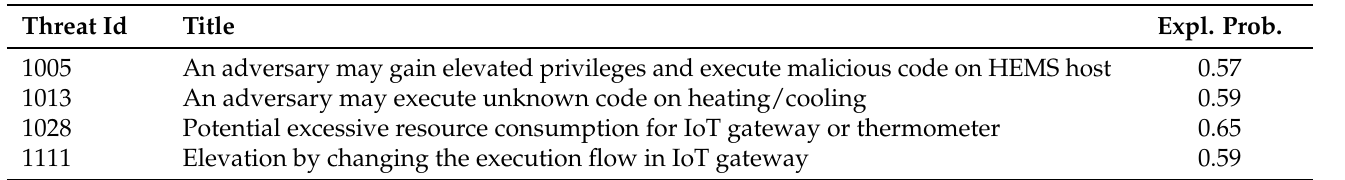
Table 3. UC1 Exploitation